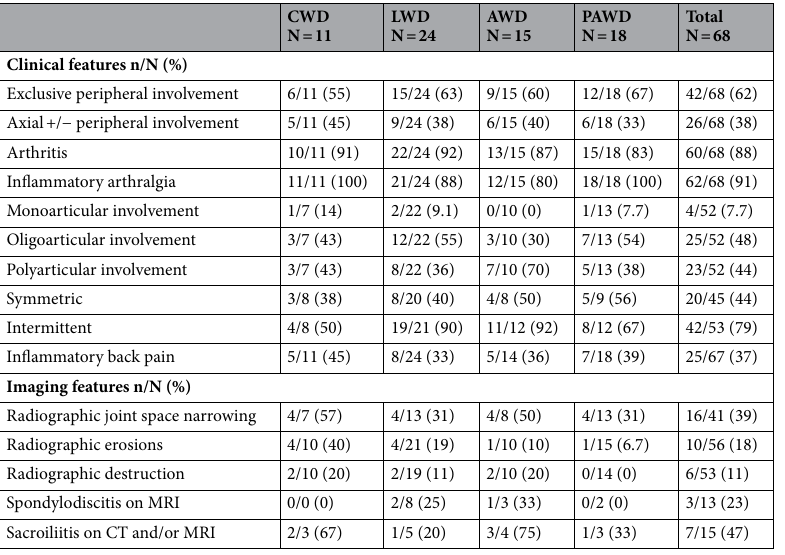
Table 2. Rheumatological clinical and imaging features according to Whipple disease entity. AWD arthropathic Whipple disease; CT computed tomography; CWD classic Whipple disease; LWD localized Whipple disease; MRI magnetic resonance imaging; PAWD probably arthropathic Whipple disease.